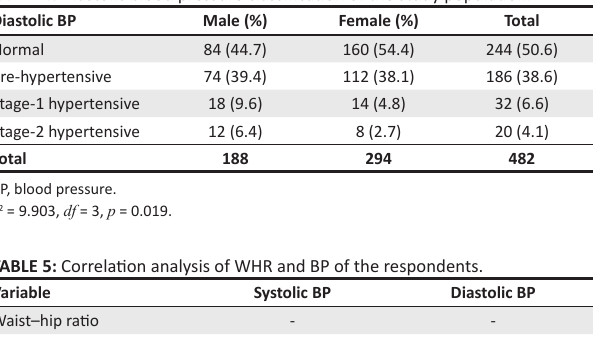
TABLE 3: Systolic and diastolic blood pressure classification of the study population. Systolic BP